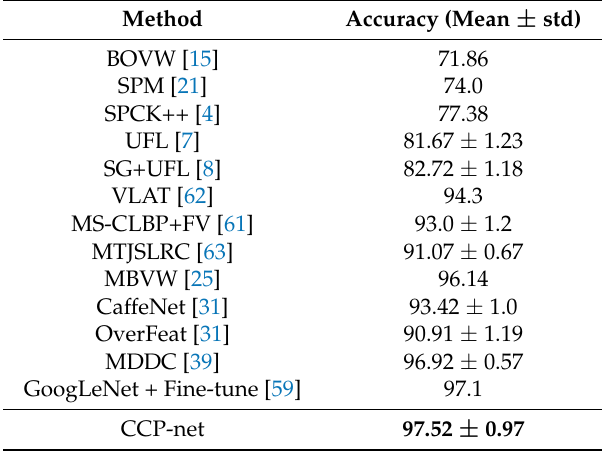
Table 2. The comparison of the classification accuracy (%) on the UC Merced